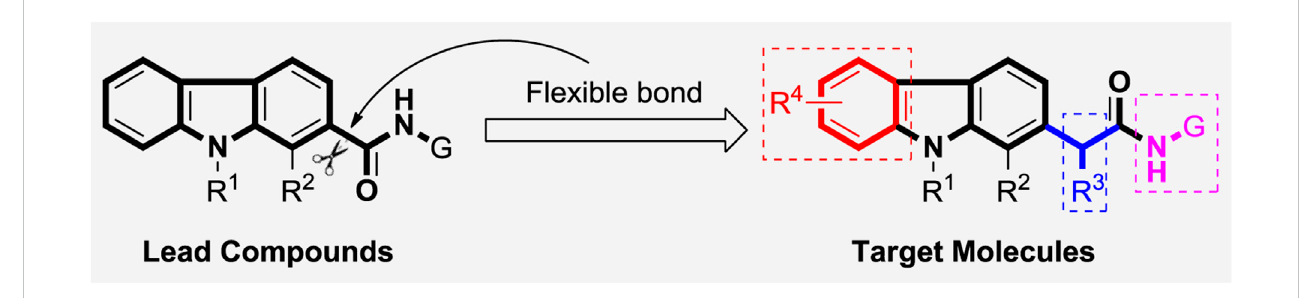
FIGURE 1 Design of novel carbazole alkaloid